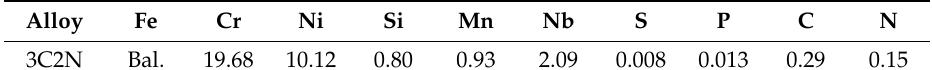
Table 1. Measured chemical composition of as-cast alloy 3C2N (mass %).